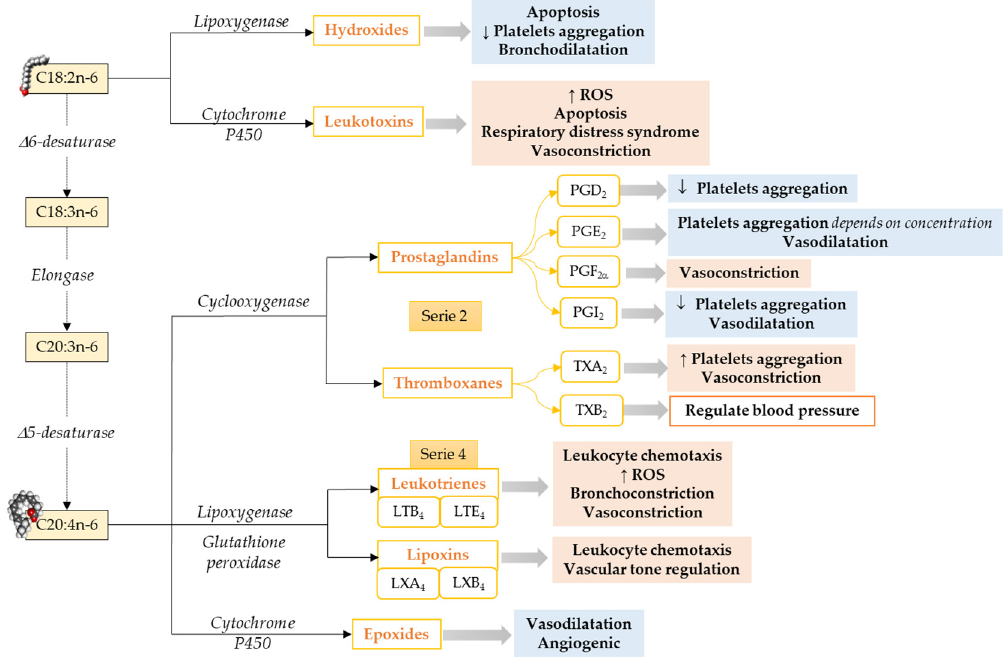
Figure 1. Pathways to synthesize n-6 LCPUFA-derived lipid mediators and their functions focusing on the cardiovascular system and vascular endothelial function. C18:2n-6, Linoleic acid; C18:3n-6, γ -Linolenic acid; C20:3n-6; Dihomo- γ -Linolenic acid; C20:4n-6, Arachidonic acid; ROS, Reactive Oxidative Species. ↓ = Decreases; ↑ = Increases. Modified from [55] .